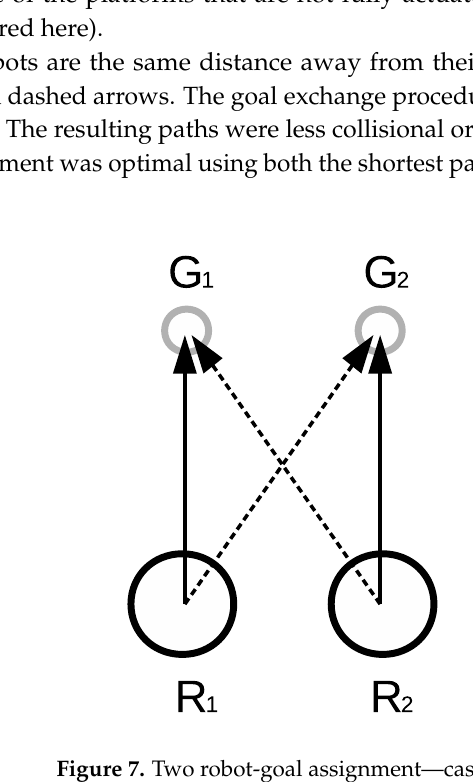
Figure 7. Two robot-goal assignment—case 1.